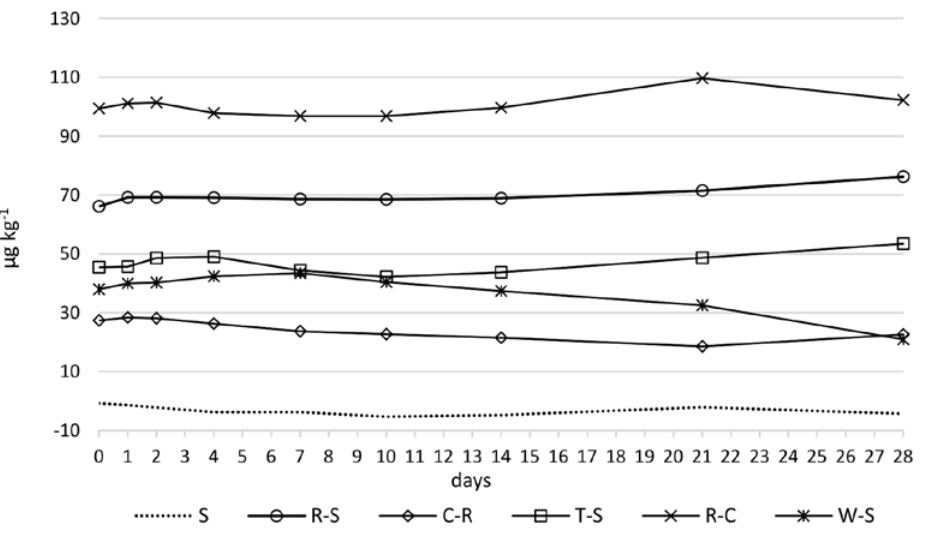
Figure 2. Cumulative methane (expressed as CH 4 -C) evolved from the amended soils during incubation. Amendments: R-S = Reed sweet-grass digestate, C-R = Common reed digestate, T-S = Tufted sedge digestate, R-C = Reed canary grass digestate, W-S = Woollyfruit sedge digestate, S = unamended soil.